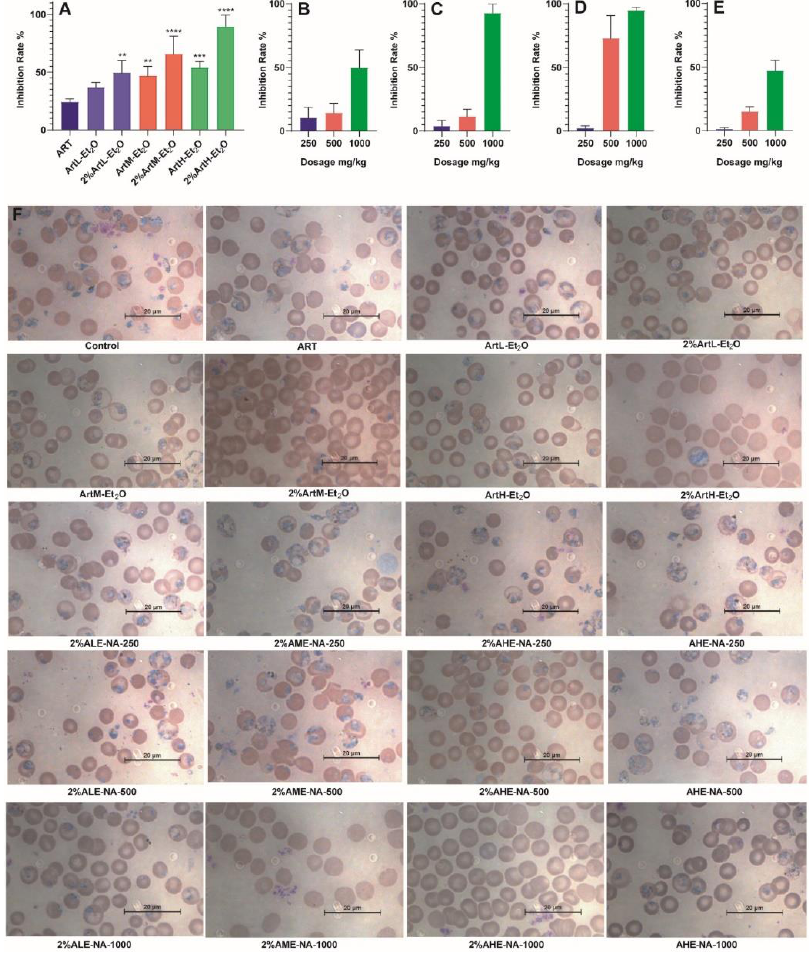
Figure 1. Results of antimalarial effect of different Artemisia annua L. parts. The data are represented as mean ± S.D., with 5 animals in each group. **, *** and **** indicate p < 0.01, 0.001 and 0.0001, respectively. ( A ) In vivo antimalarial efficacy of different extract groups and ether-neutral-dry groups. ( B ) In vivo antimalarial efficacy of 2% ALE-NA in different dosage groups. ( C ) In vivo antimalarial efficacy of 2% AME-NA in different dosage groups. ( D ) In vivo antimalarial efficacy of 2% AHE-NA in different dosage groups. ( E ) In vivo antimalarial efficacy of AHE-NA in different dosage groups. ( F ) Representative photomicrograph of blood smears of untreated control group and treatment